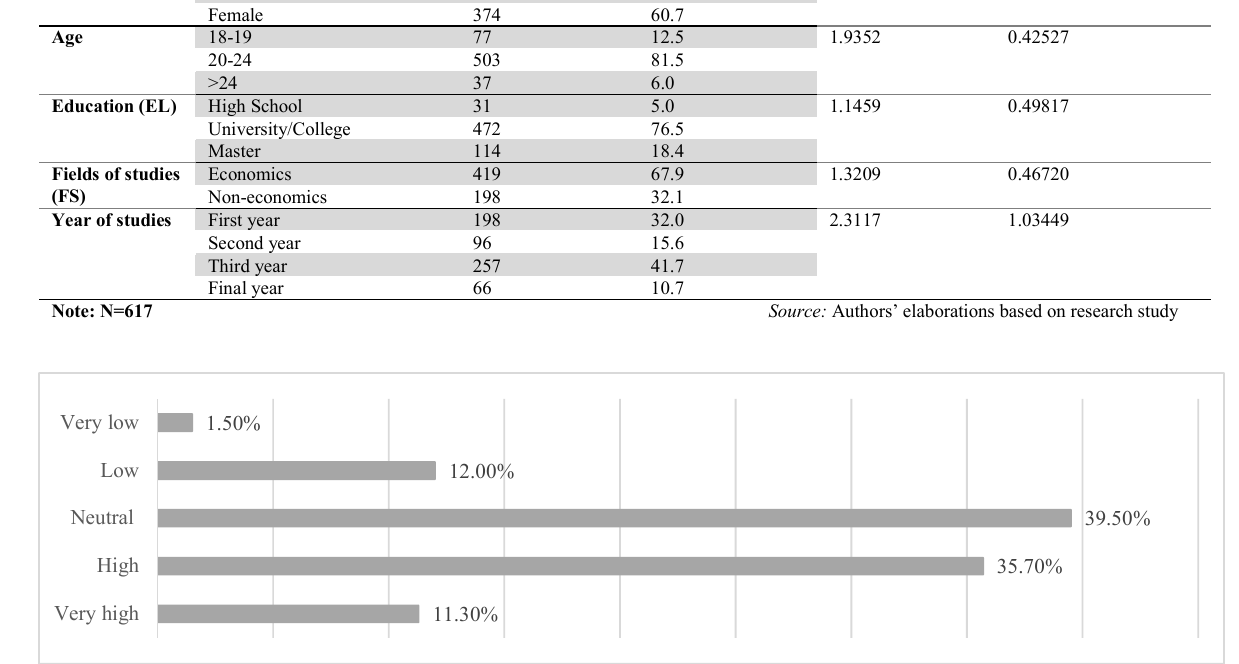
Fig 2 . Respondents’ willingness level to take the